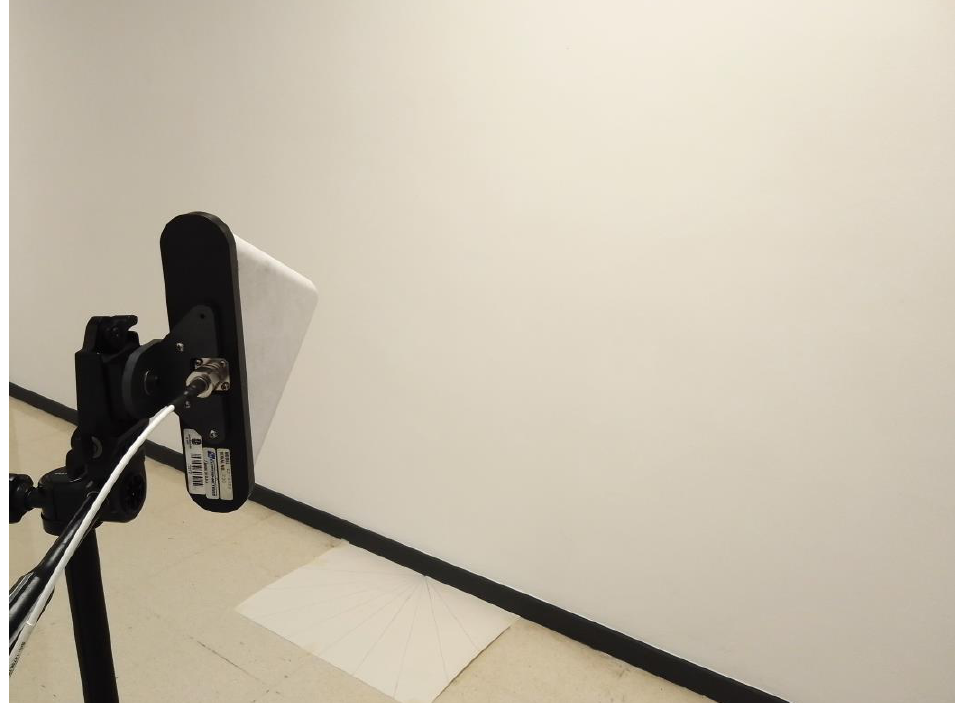
Figure 11. 15 cm facade made of brick.